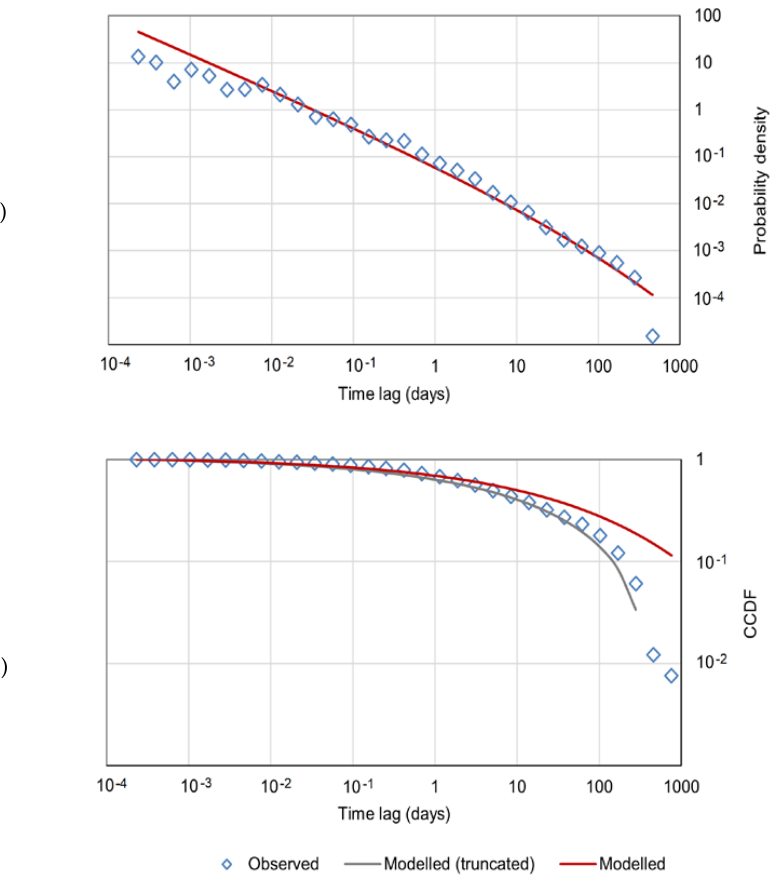
Figure 9. Time lag test results: reconstruction of the distribution of the time lag between triggered events and their ancestors from observations. ( a ) Plot of probability density. ( b ) Plot of complementary cumulative distribution function (CCDF). To check the hypothesis that the deviation of the observed curve is explained by the time boundary effect, an alternative CCDF is also shown where the time lag is truncated at 400 days.